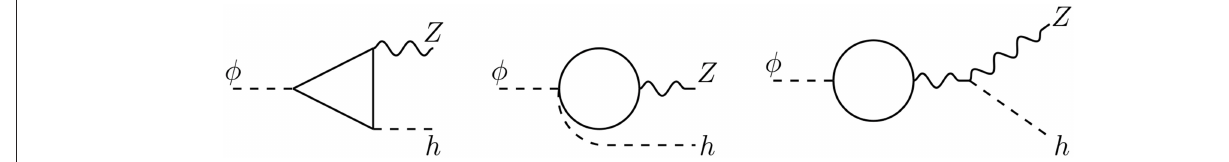
FIGURE 1 | Leading contributions to the decay φ